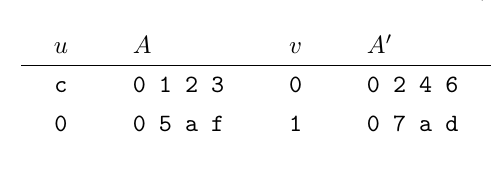
Table 4: Affine invariant subspaces for Sb 0 with A 6 = A 0 , | A | = | A 0 | =